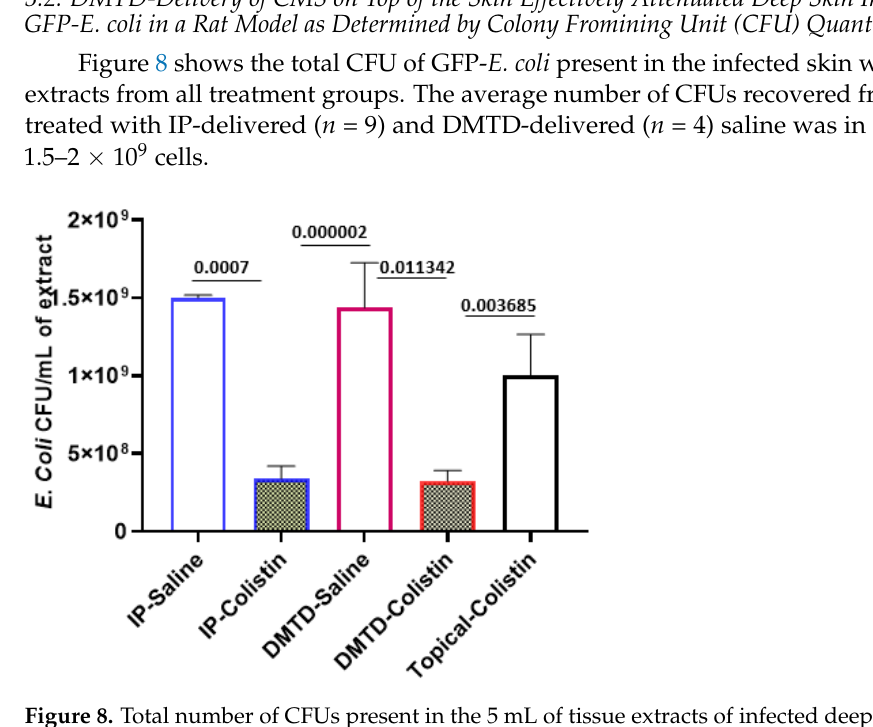
Figure 8. Total number of CFUs present in the 5 mL of tissue extracts of infected deep skin wounds that were treated with IP-delivered saline (IP-saline) or colistin (IP-colistin), DMTD-delivered saline (DMTD-saline) or colistin (DMTD-colistin) and topical application of equal dose of colistin (Topical colistin). The actual p values are shown on top of the bars.